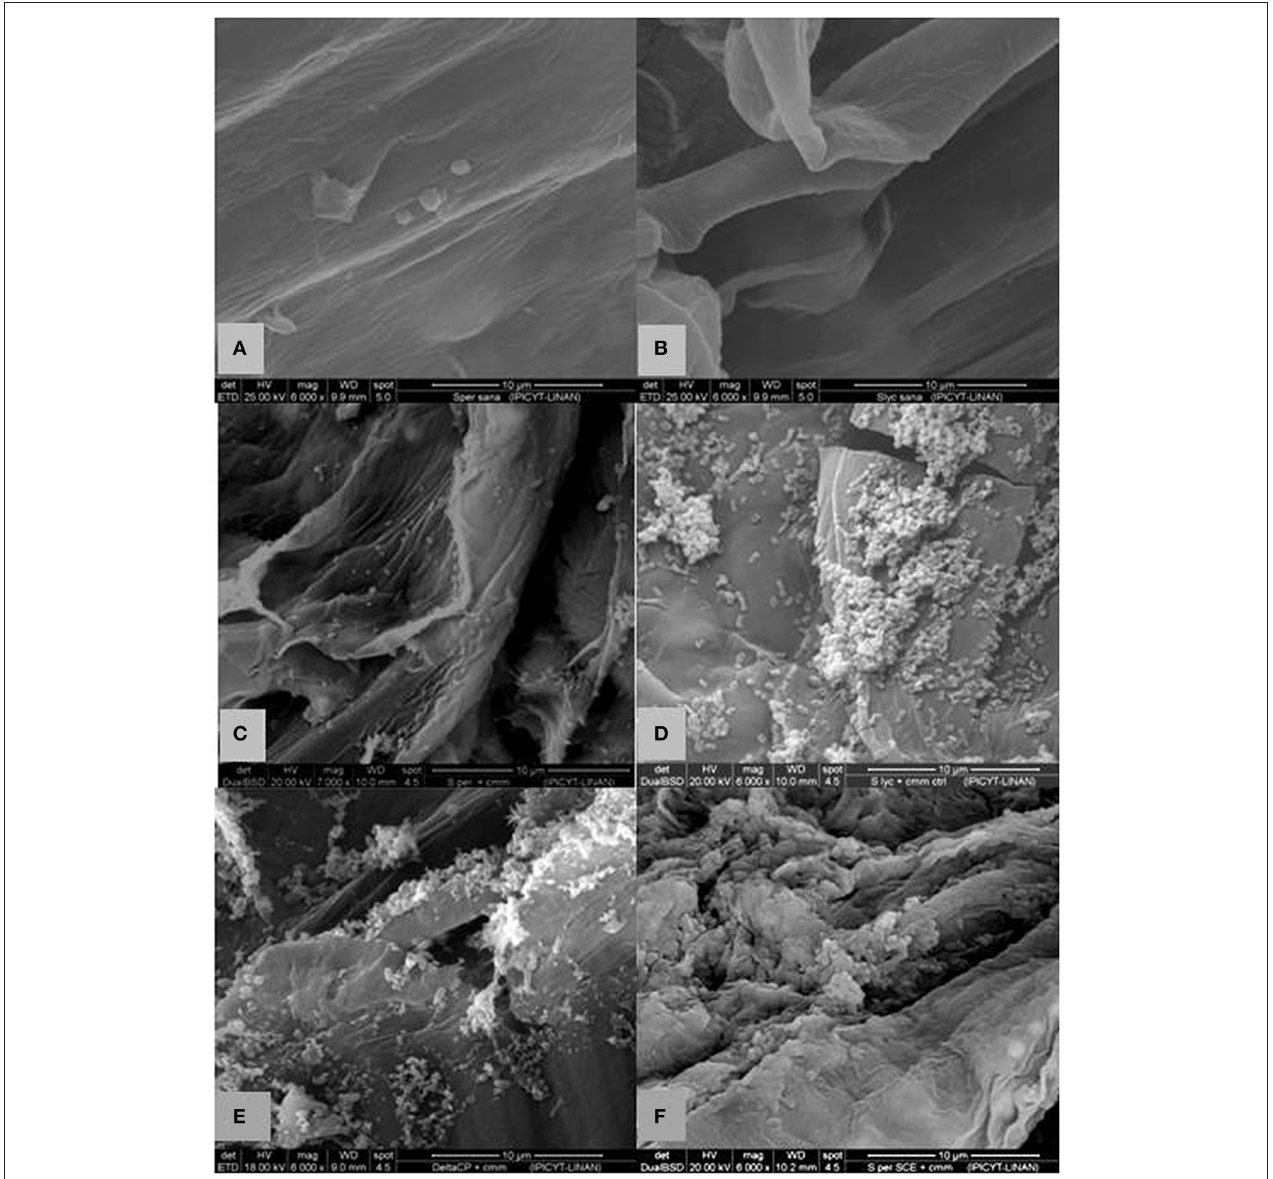
FIGURE 7 | Scanning electron microscopy of longitudinal cut of a stem of non-treated, empty vector and SCE I-silenced Solanum plants with and without Cmm challenge. (A) S. peruvianum without inoculation of Cmm showing no bacteria or tissue damage (B) S. lycopersicum without inoculation of Cmm showing no bacteria or tissue damage (C) non-VIGS treated S. peruvianum at 10 dpi with Cmm showing some bacterial but limited parenchymal tissue damage. (D) S. lycopersicum at 10 dpi with Cmm revealing more bacterial structures with greater parenchymal tissue damage. (E) empty-vector treated S. peruvianum at 10 dpi with Cmm with some bacterial structures and limited parenchymal tissue damage. (F) SCE I-silenced S. peruvianum at 10 dpi with Cmm revealing considerable bacterial structures and parenchymal tissue damage. Magnification 6000x, scale bar ∼ 10 µ